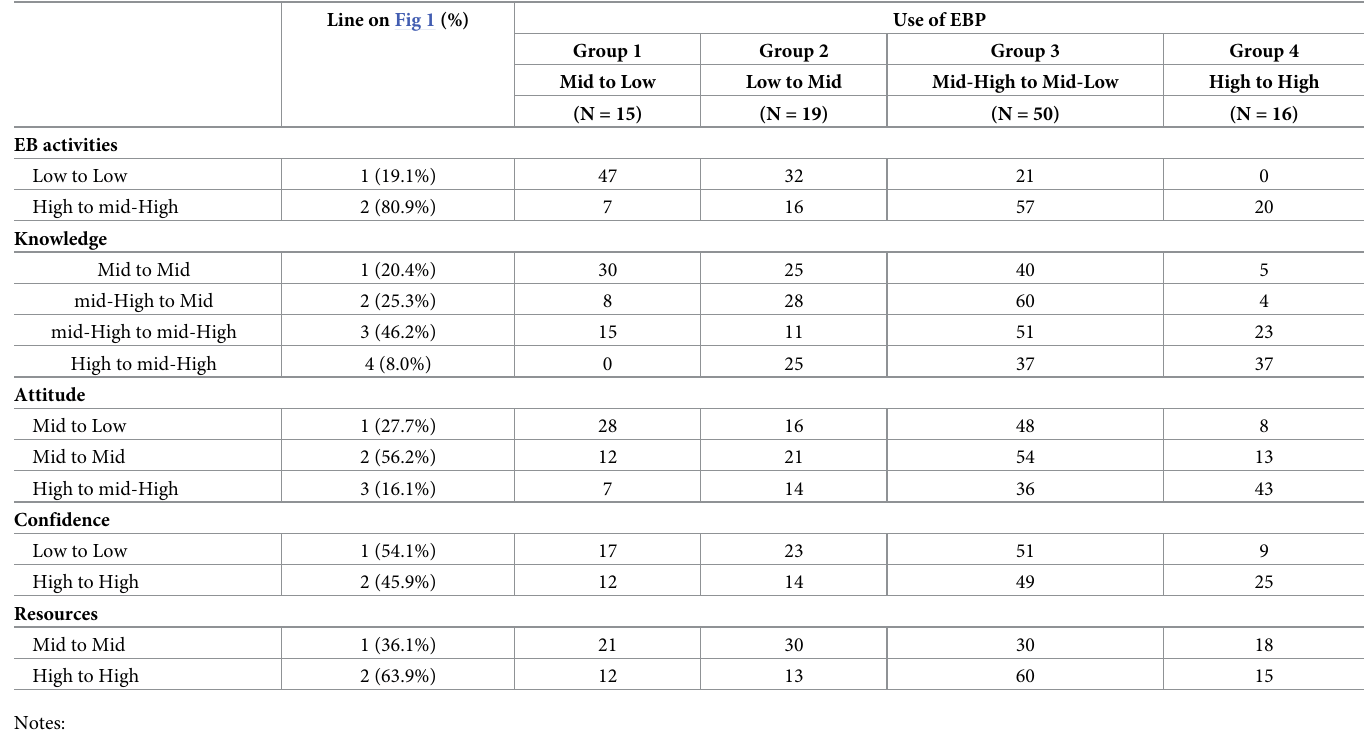
Table 2. Cross tabulations of prevalence of use of EBP with EB activities, knowledge, attitudes, confidence, and resources. Line on Fig 1